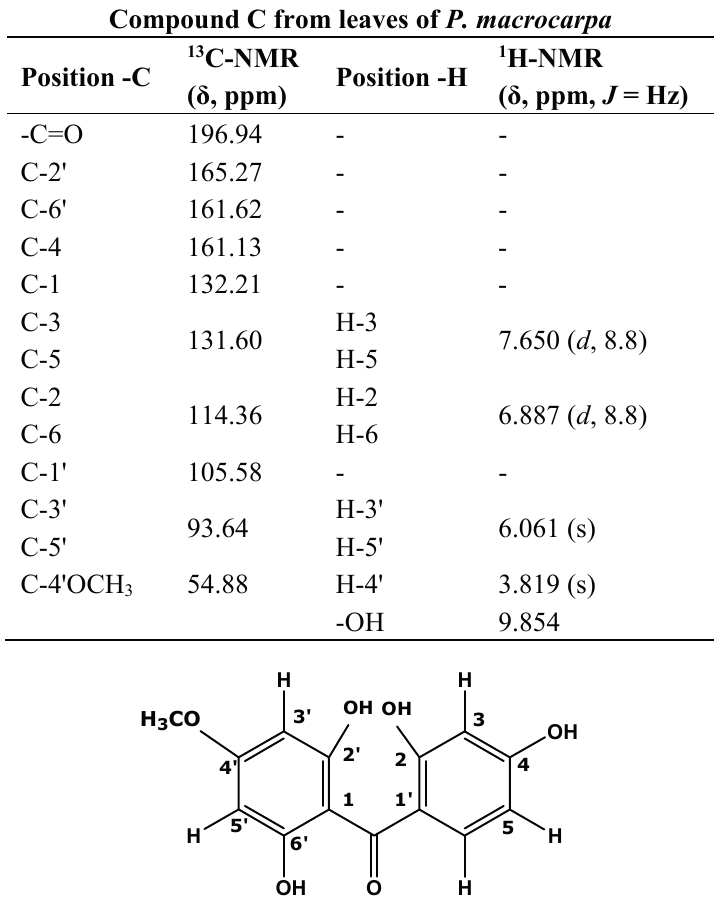
Table 1. 1D-NMR ( 1 H- and 13 C-NMR) assignments (400 MHz, acetone- d 6 ) for compound (C) compared to the literature.